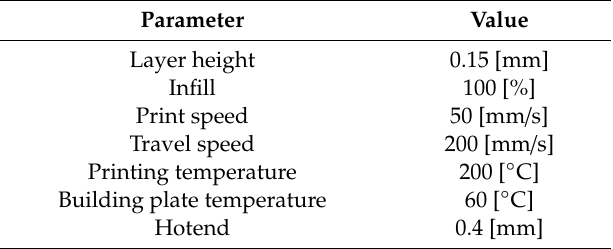
Table 4. 3D printing parameters of the specimens.